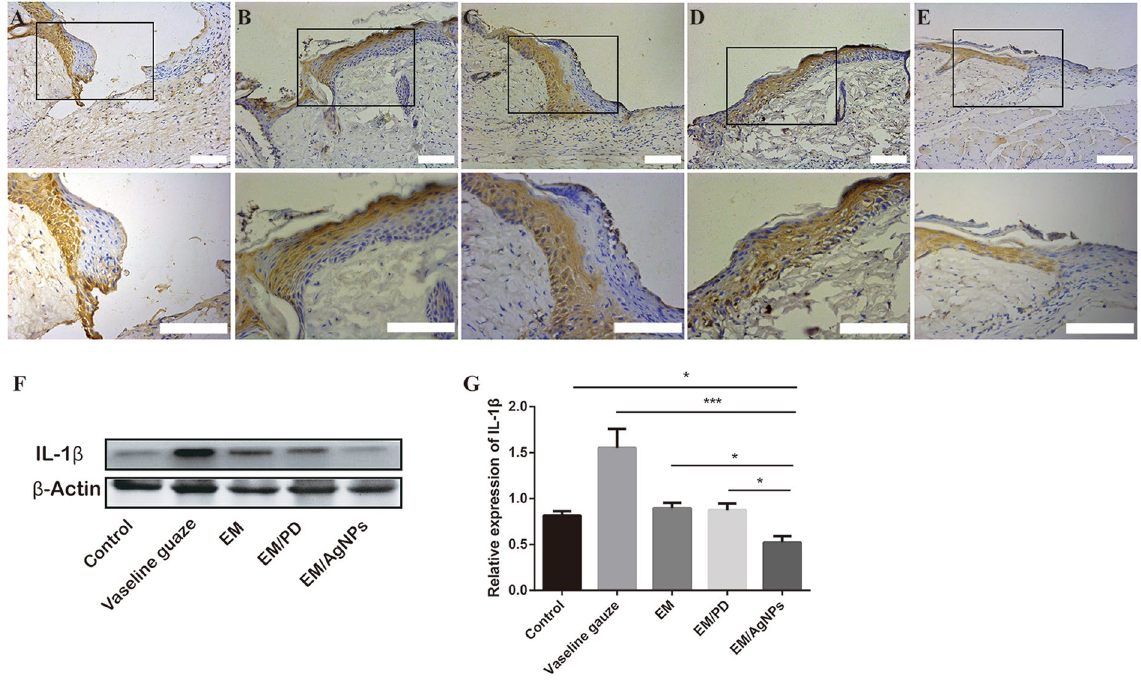
Figure 12. The detection of IL-1 β in wound tissue at day 3 post-surgery. Representative images of immunohistochemical staining of IL-1 β in the ( A ) Control, ( B ) Vaseline gauze, ( C ) EM, ( D ) EM/PD and ( E ) EM/AgNPs groups (n = 5). The rectangular insets indicate magnified areas. ( F ) The levels of IL-1 β protein in the full-thickness wound tissues, as detected by Western blotting, and ( G ) the optical density values of the IL-1 β bands. The values are shown as the mean ± SD (n = 3). Scale bars: 100 μ